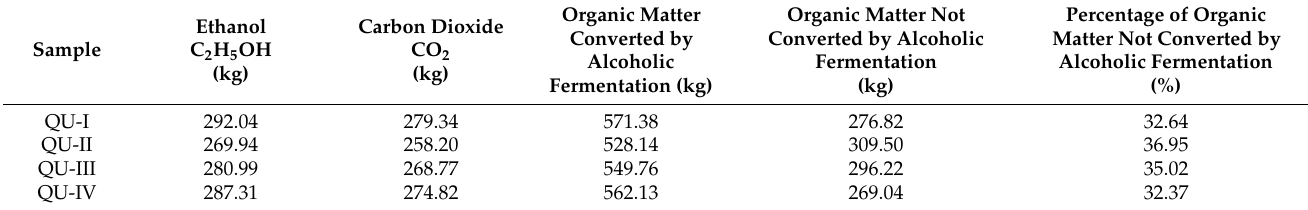
Table 6. Conversion of organic matter into ethanol and carbon